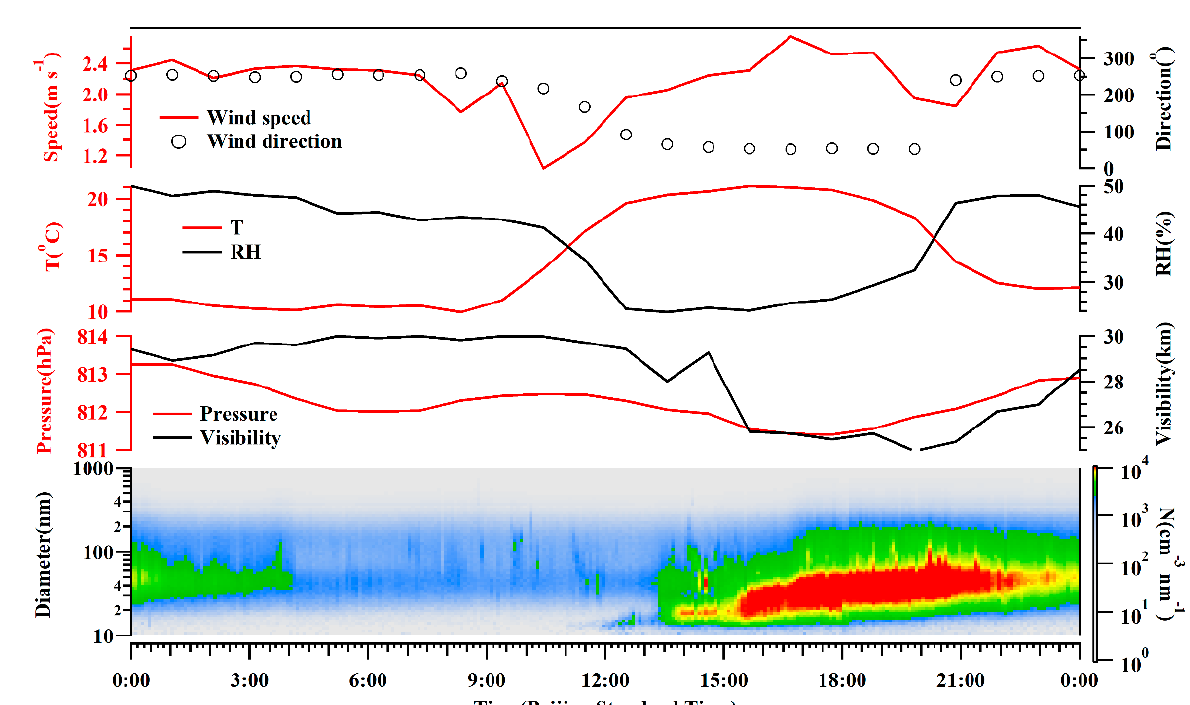
Figure 7. Diurnal variations of aerosol size distribution and meteorological elements near ground observation.